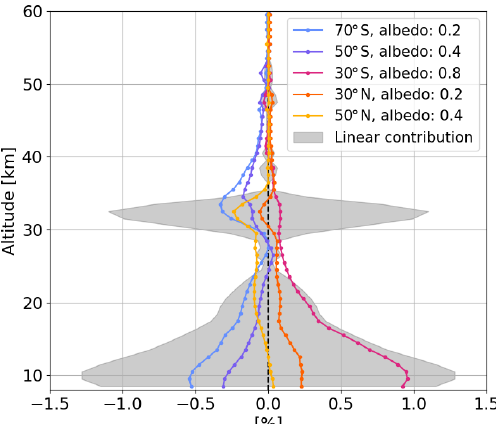
Figure 11. Relative difference between the results with and without polarization for several latitude and surface albedo combinations. The shaded area refers to contribution of the polarization from the linear error propagation, as given by Eq. (10).